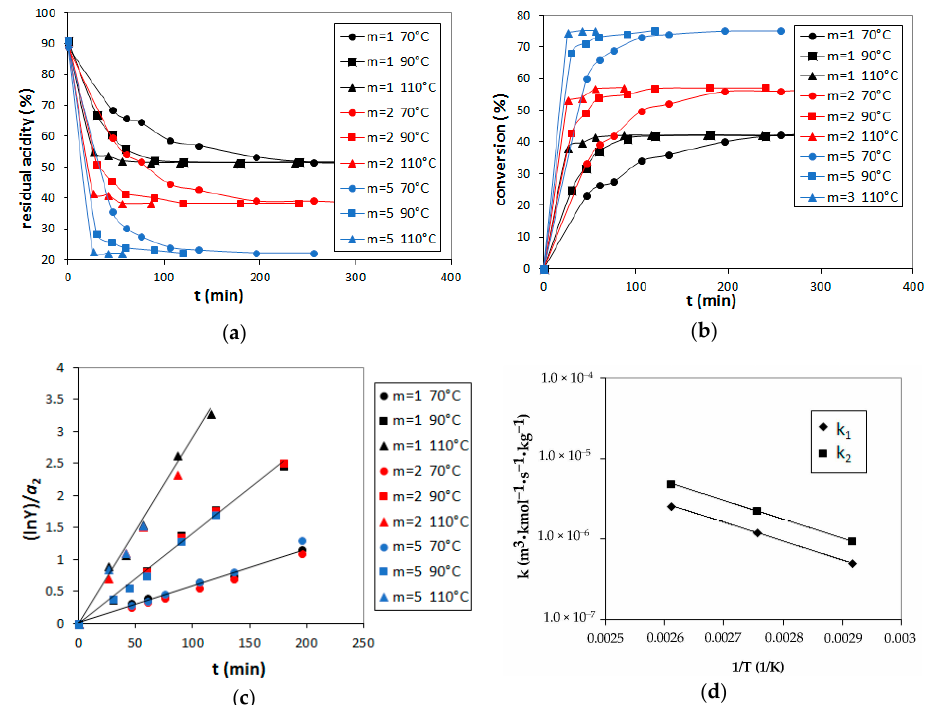
Figure 4. Evaluation of the kinetic parameters for the esterification of palmitic acid with methanol with Amberlyst-15: ( a ) residual acidity; ( b ) conversion profiles; ( c ) plot of (ln Y )/ a 2 versus time at different temperatures and methanol/acid molar ratios (m); and ( d ) forward and backward rate constant versus 1/T.